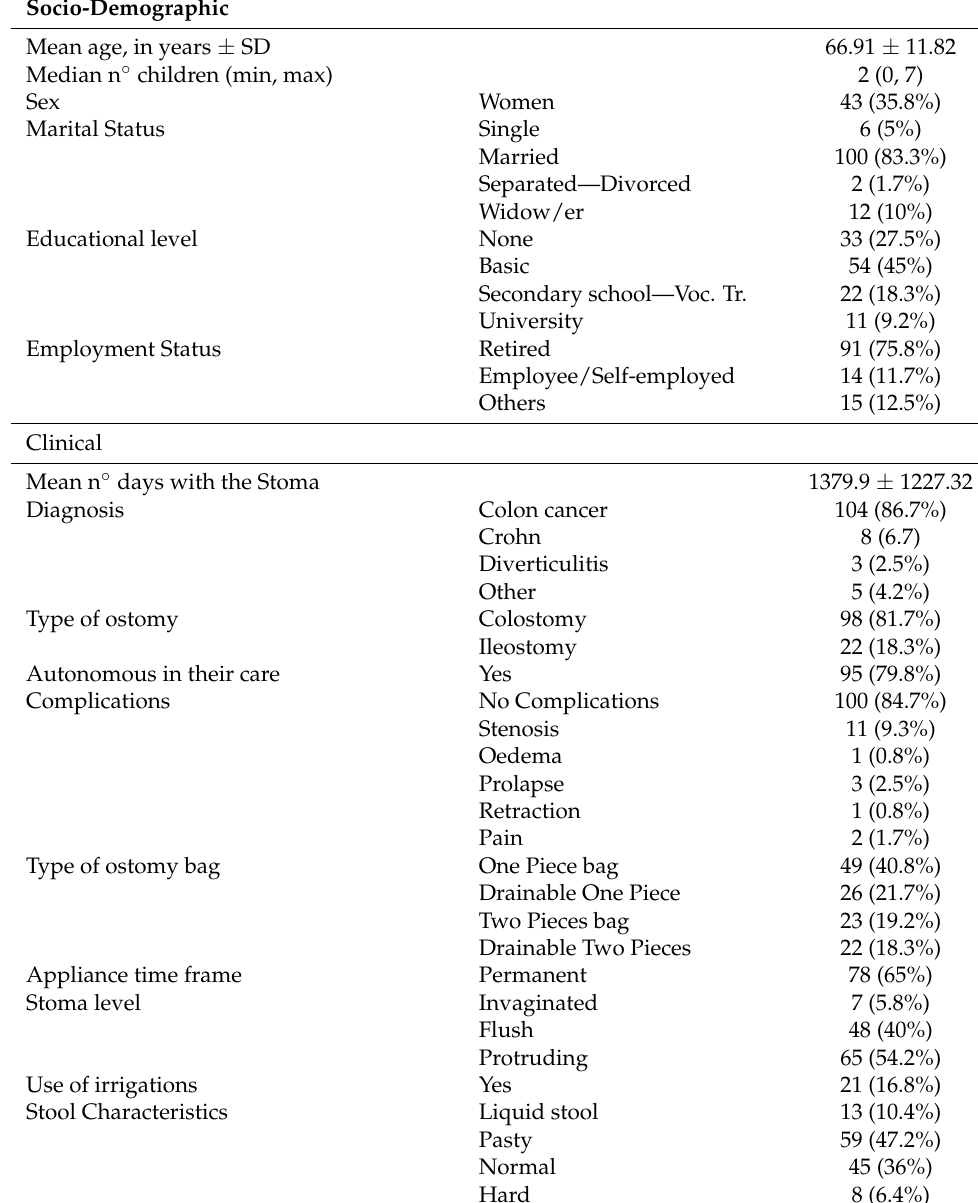
Table 2. Characteristics of the subjects included in the